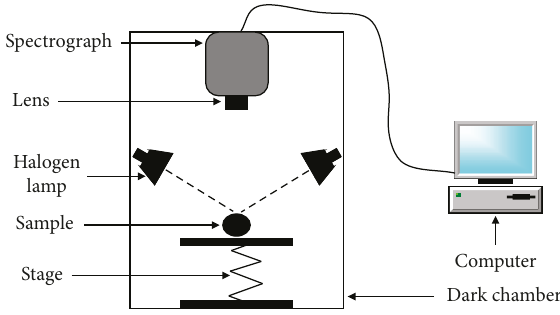
Figure 1: Schematic diagram of the experimental